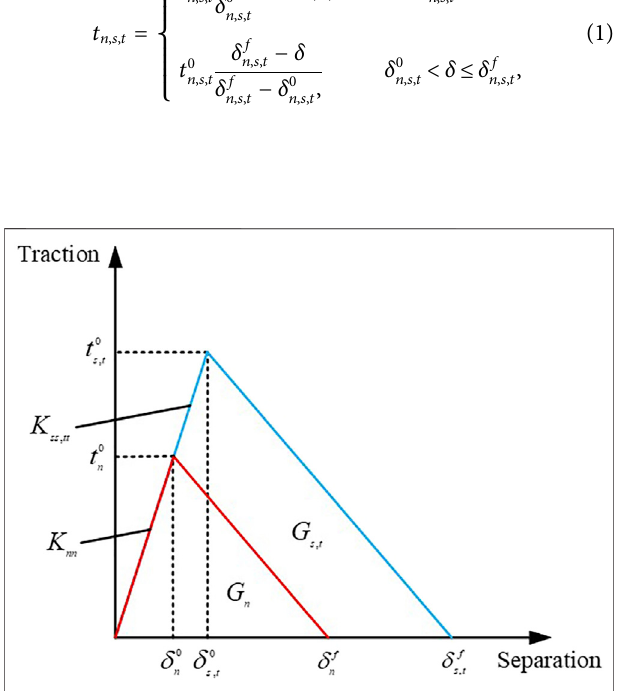
FIGURE1| Constitutivemodelofthecohesiveinterfaceelement(bilinear constitutive model).